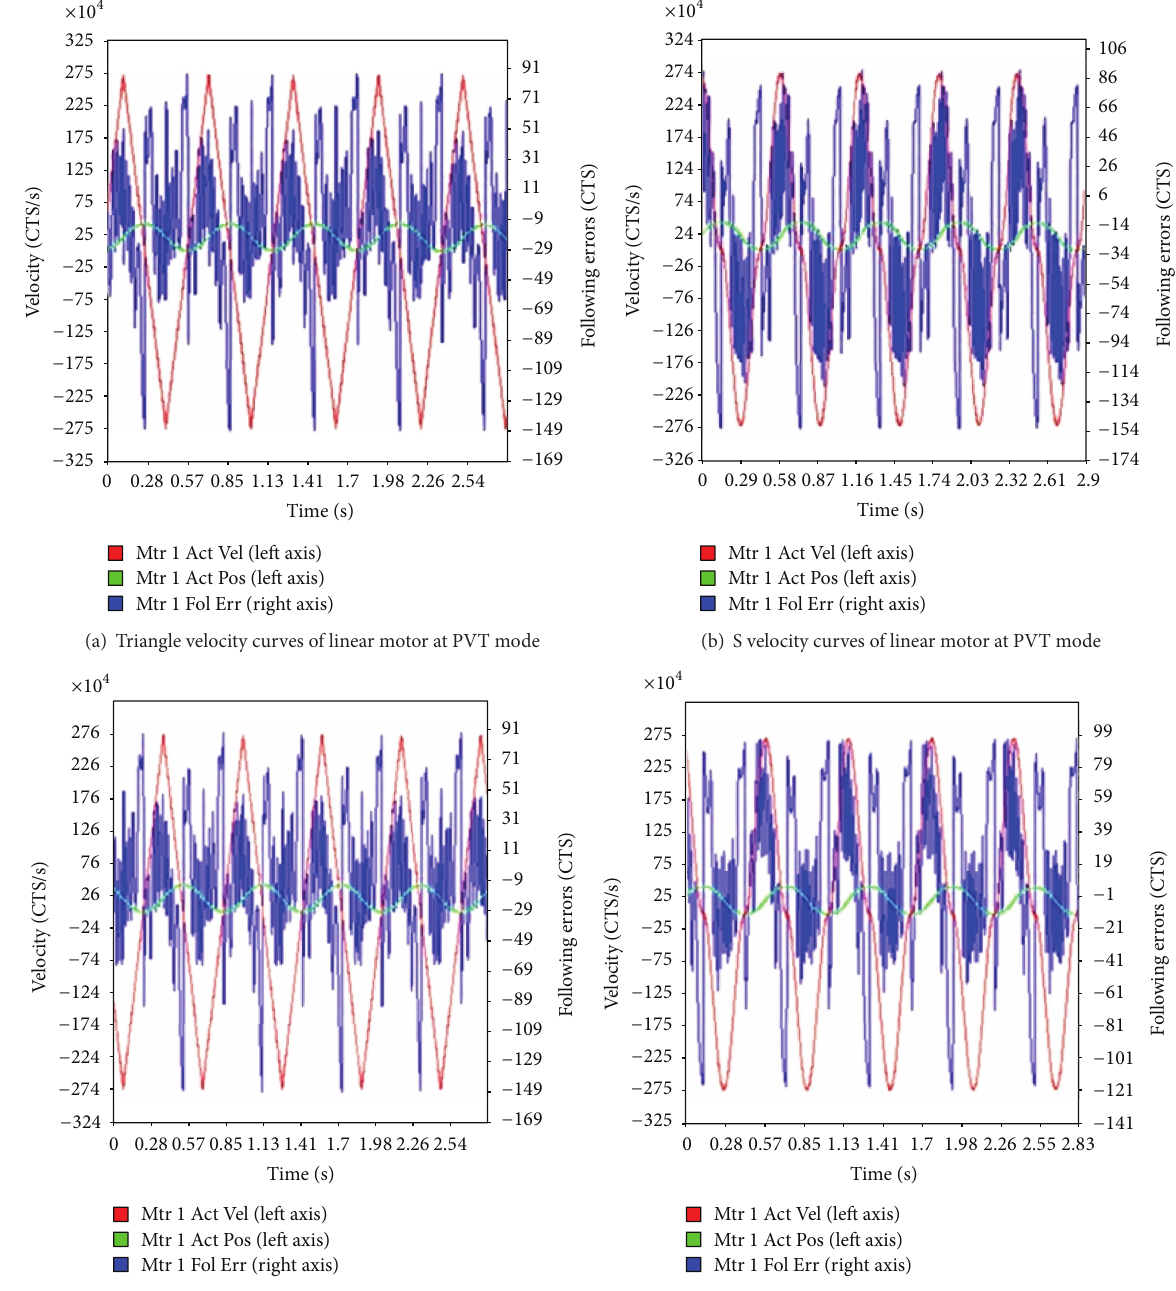
(c) Triangle velocity curves of linear motor at spline mode (d) S velocity curves of linear motor at spline mode Figure 7: Debugging diagram under different motion modes and